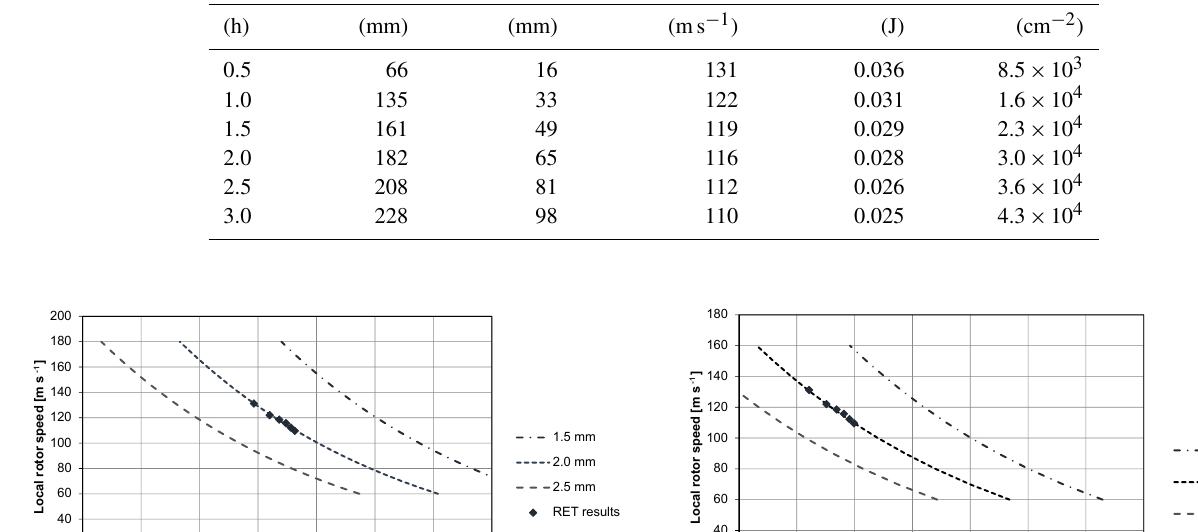
Table 1. Erosion propagation as a function of time. Test Position of Accumulated Tangential speed Kinetic energy, Impacts/area to time erosion front rain at erosion front of each impact removed coating